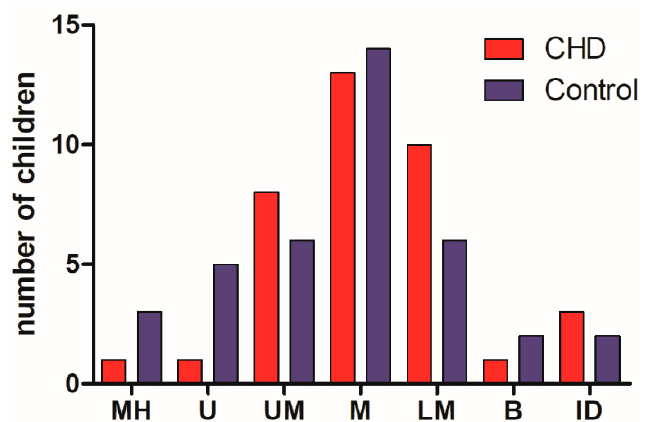
Figure 3. Distribution of children in intelligence classes using the R2 nonverbal intelligence test. MH: much higher; U: upper; UM: upper mean; M: mean; LM: lower mean; B: borderline; and ID: intellectually disabled.